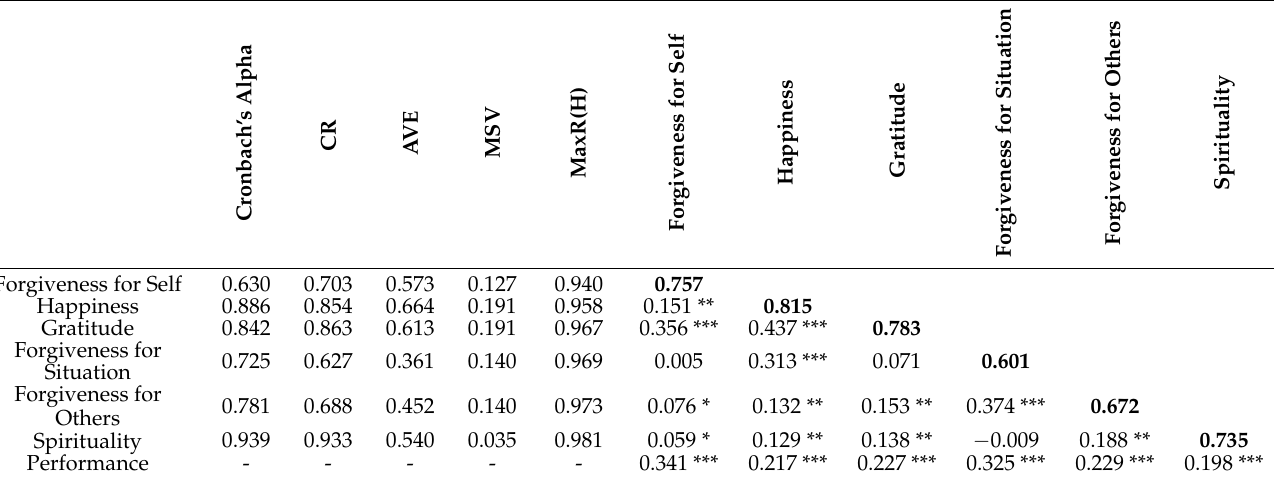
Table 2. The inter-construct correlations, reliabilities, and validity statistics at time